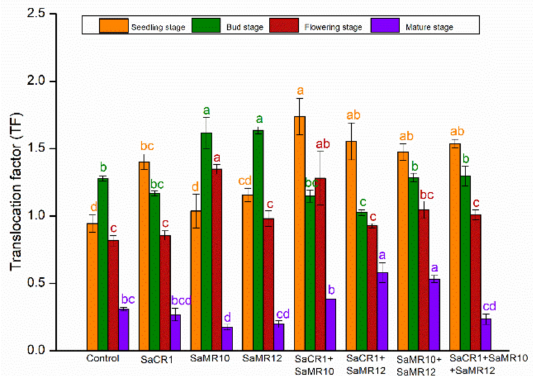
Figure 7. Effects of PGPB inoculants on the translocation factor of B. juncea at different growth stages. Orange, green, red, and purple represent the seedling stage, bud stage, flowering stage, and mature stage, respectively. The letters of corresponding colors indicate the significant differences among different treatments at the same growth